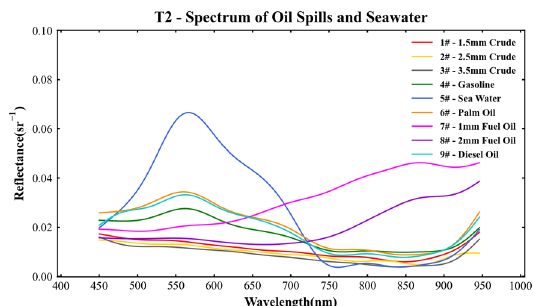
Figure 11. Remote sensing reflectance of the oil spills at T2.